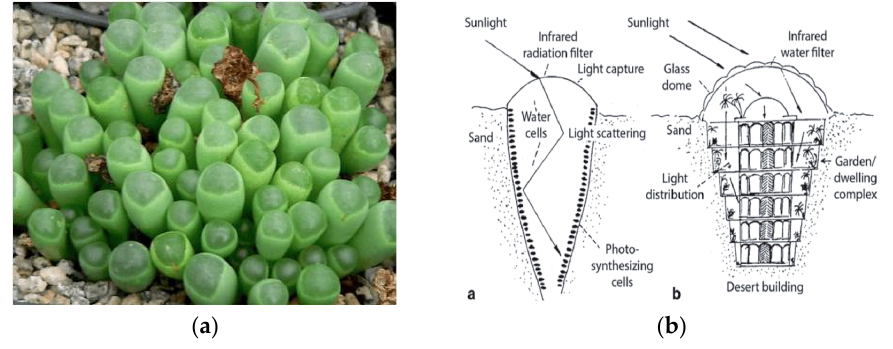
Figure 3. ( a ) Fenestraria aurantiaca [28]; ( b ) a. Abstracted from the build-concept of the stone plant Frithia pulchra (Adapted from Tributsch 1995): b. Concept sketch for a desert building [28].